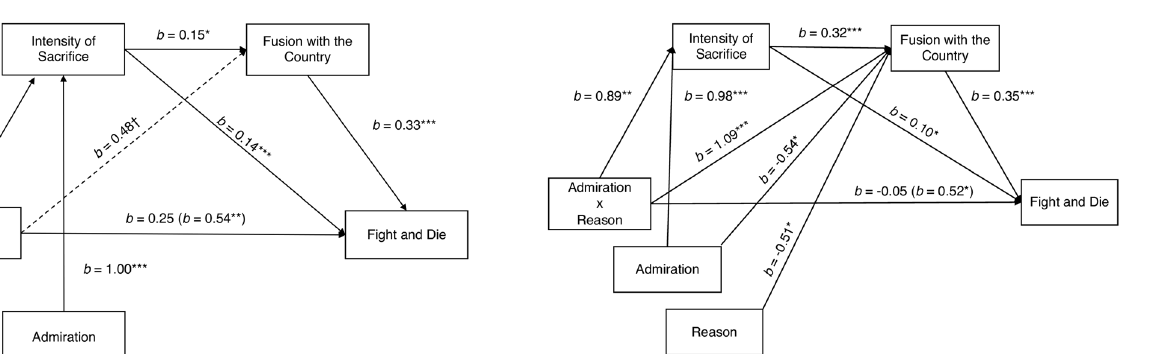
[0.005, 0.12]. The indirect effect via identity fusion alone was not indirect effect was also signi fi cant, but weaker than in the ingroup conditions, b = 0.10, 95% CI [0.02, 0.21]. Note: * p < 0.05; ** p <